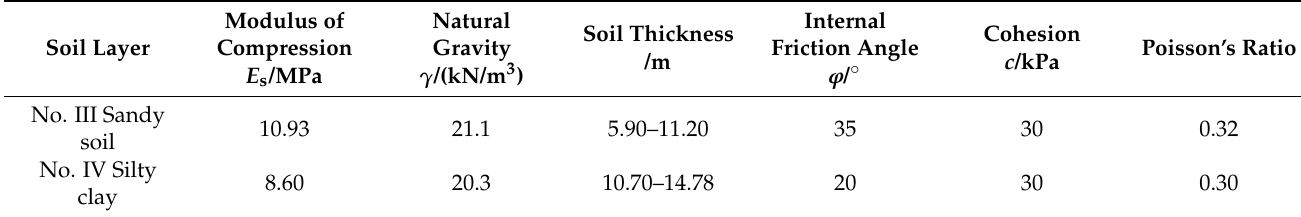
Table 1. Physical and mechanical characteristics of soil samples.